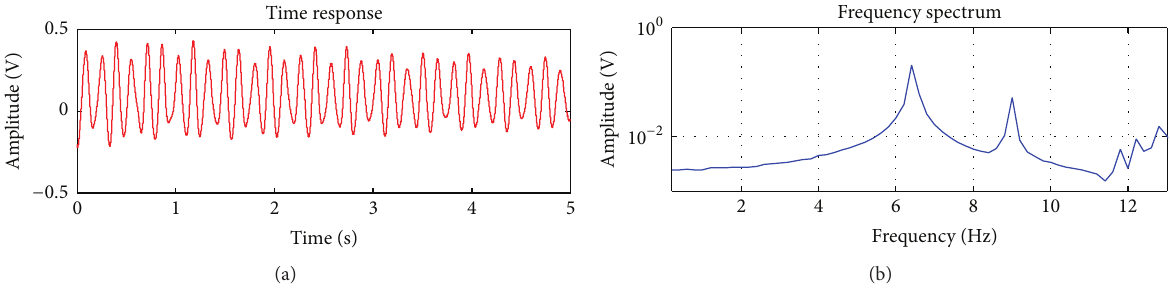
Figure 8: Transient response of the primary structure with a tip impact and with absorber. (a) Time history of the primary structure; (b) frequency spectrum of the response.